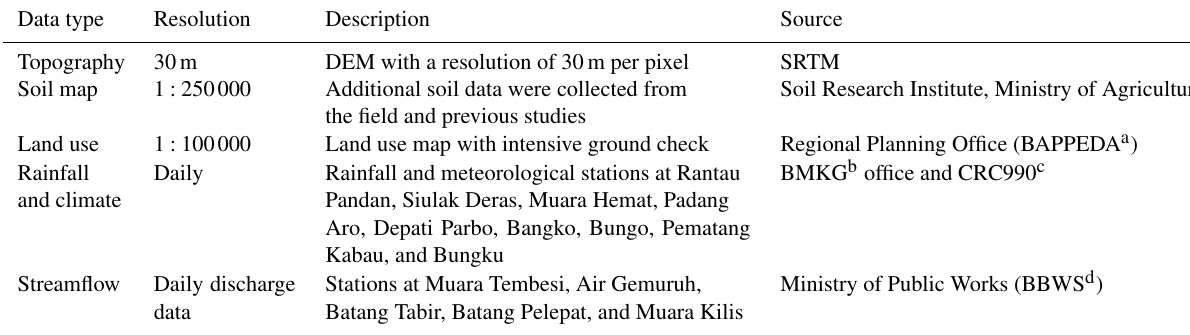
Table 3. Model input data sources. Data